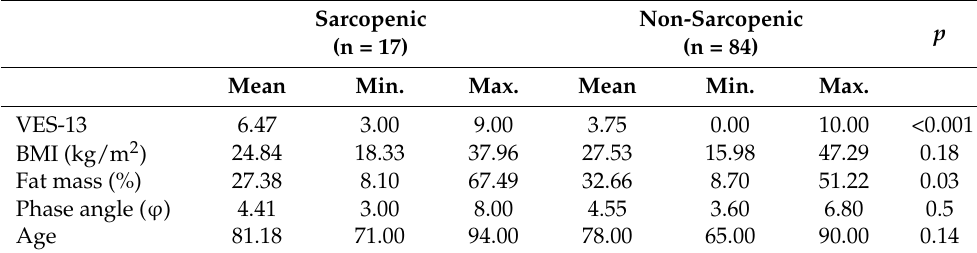
Table 3. Comparison of sarcopenic and non-sarcopenic